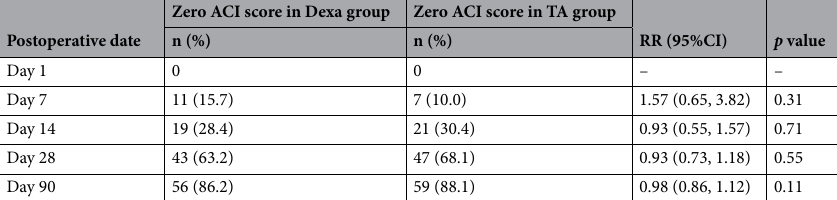
Table 2. Proportion of zero anterior chamber inflammation (ACI) score at each study visit. No difference in proportion of patients who had zero ACI score was noted in any visit between two groups. Dexa group = 0.1%